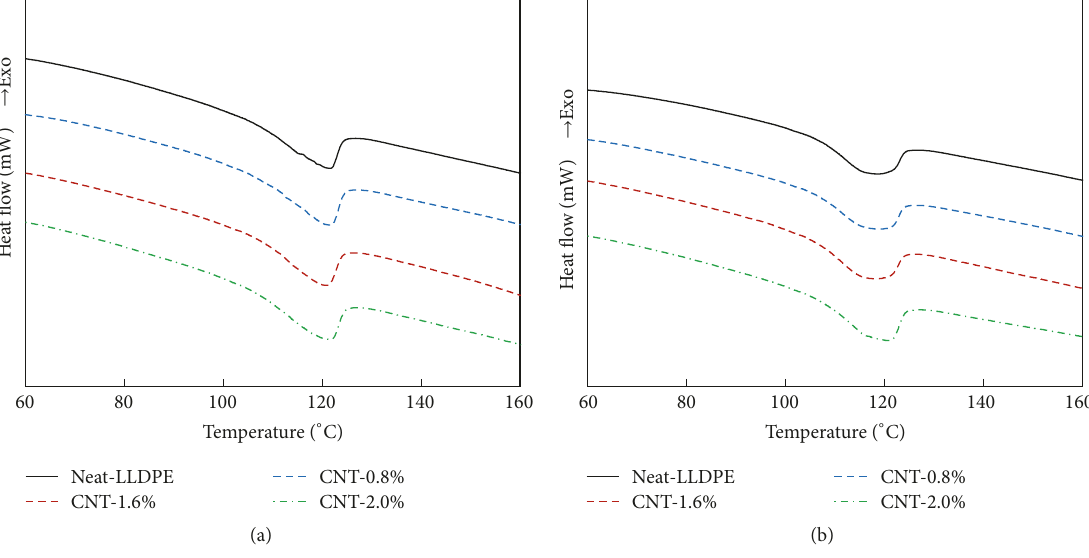
LLDPE fiber. The XRD peaks at 21.6 ∘ and 24.0 ∘ were